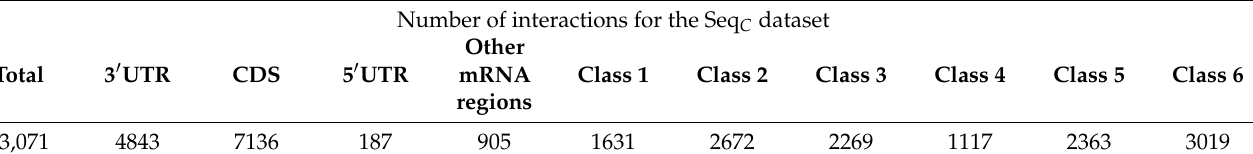
Table 2. Number of interactions for each mouse dataset, in total and distributed by region and class. Number of interactions for the Seq C